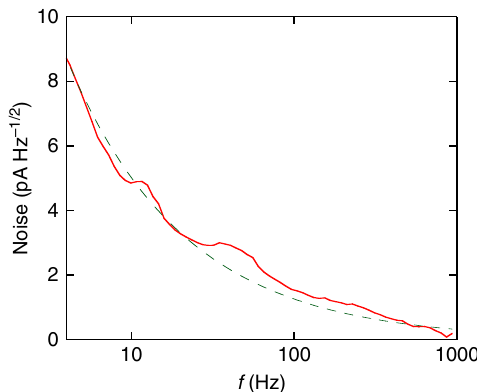
Fig. 4 Noise spectrum. Noise is plotted as a function of frequency at n s = 5.36 × 10 10 cm − 2 , T = 60 mK and V = 4.26 mV with resolution/bandwidth 2.5 Hz. The broad maxima at f ~ 10 and 60 Hz on the order of 1 pA Hz − 1/2 are within the experimental uncertainty. The dashed line shows the 1/ f